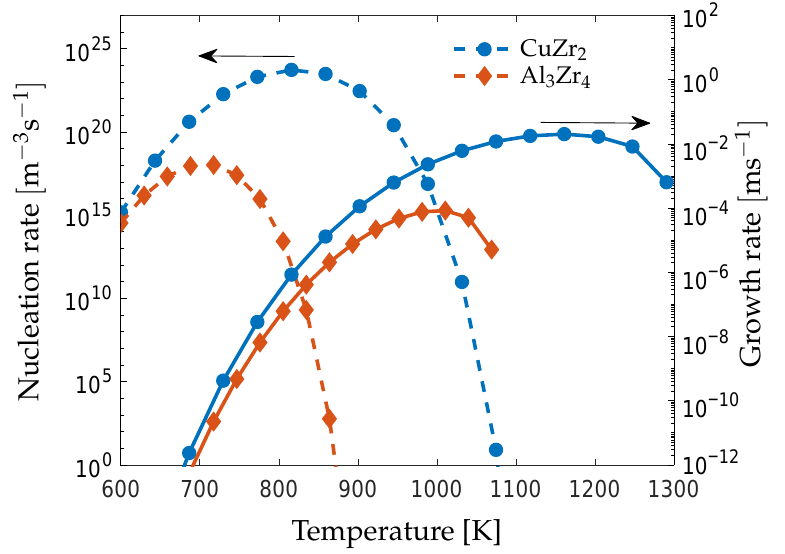
Figure 3. Nucleation rate (dashed line, left scale) and maximum growth rate (solid line, right scale) of the CuZr 2 and Al 3 Zr 4 phases from a matrix composition of Al 10 Cu 30 Zr 60 .